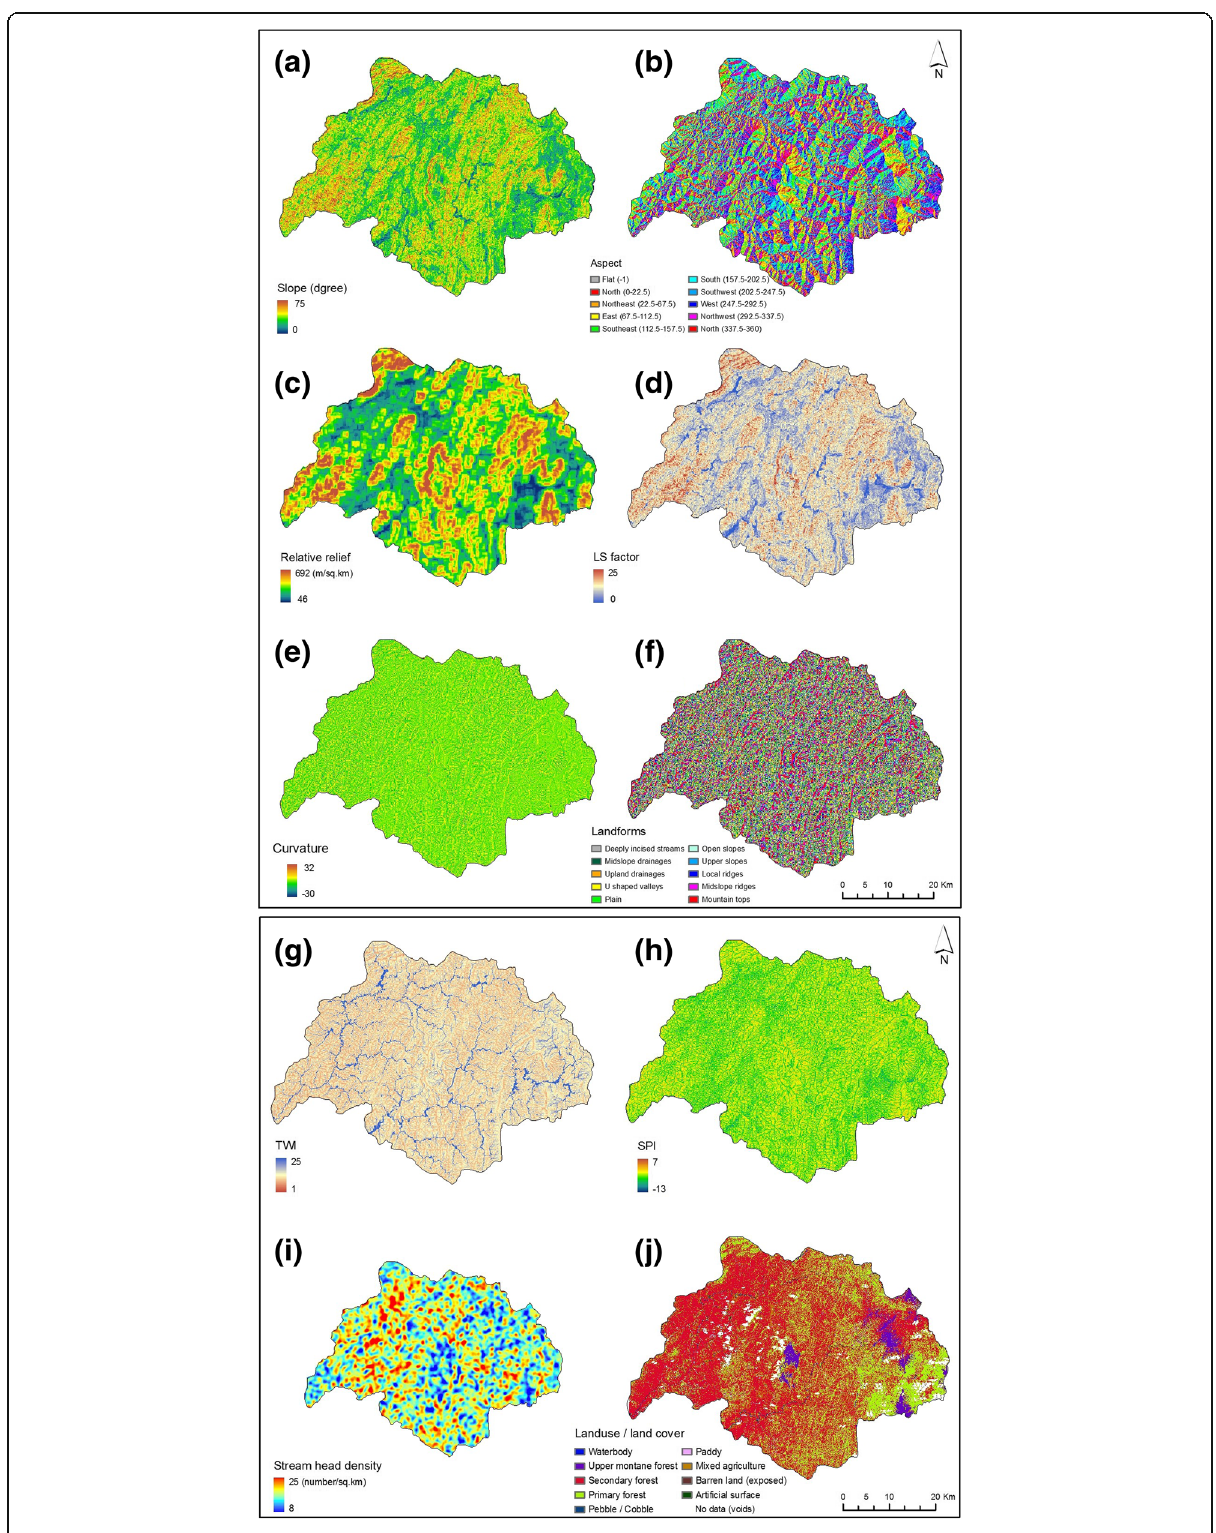
Fig. 3 Geo-environmental variables used in the analysis a Slope b Aspect c Relative relief d Slope length and steepness (LS) e Curvature f Landforms g topographic wetness index (TWI) h Stream power index (SPI) i Stream head density j Land use/land